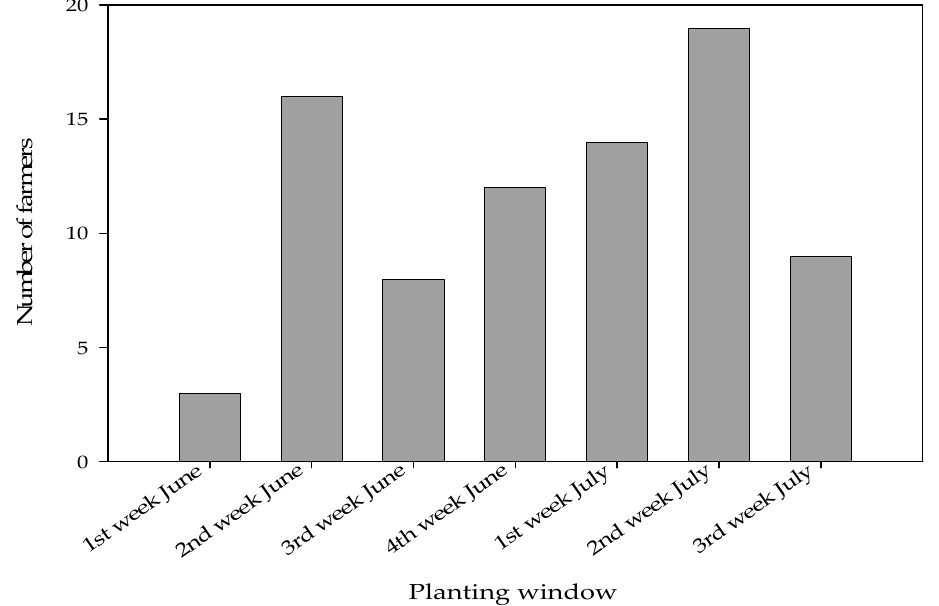
Figure 3. Distribution of planting dates for soybean in the study area in the 2017 agronomy sur- vey. Table 1. Soil parameters used in the evaluation of the model.